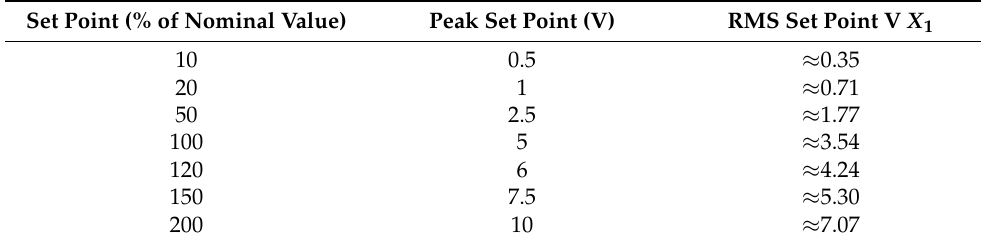
Table 3. Steady-state signal magnitude test